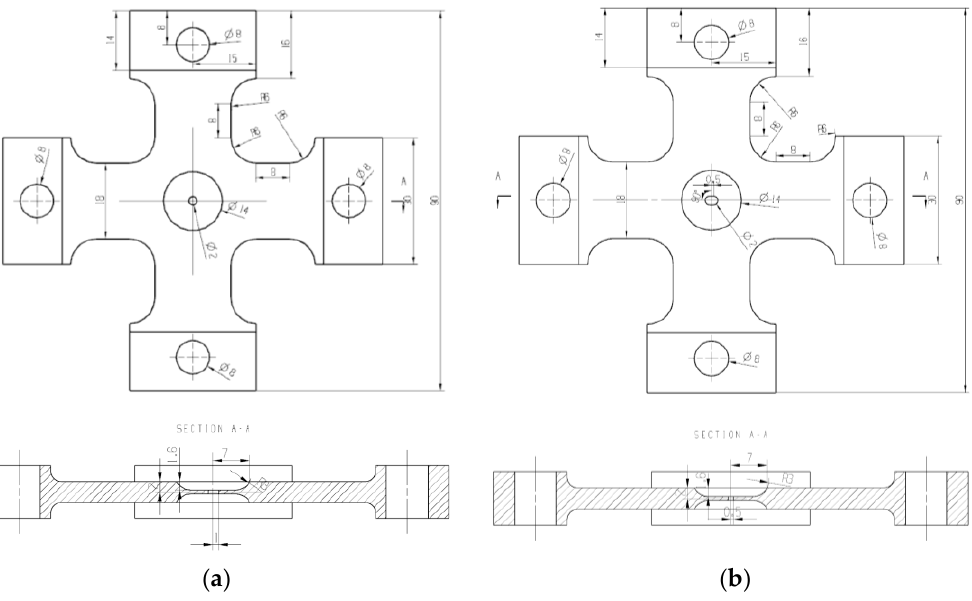
Figure 2. Geometry and dimensions of cruciform specimen (mm). ( a ) Cruciform specimen with circular notch in the central area. ( b ) Cruciform specimen with 0° waist circle hole notch in the central area.